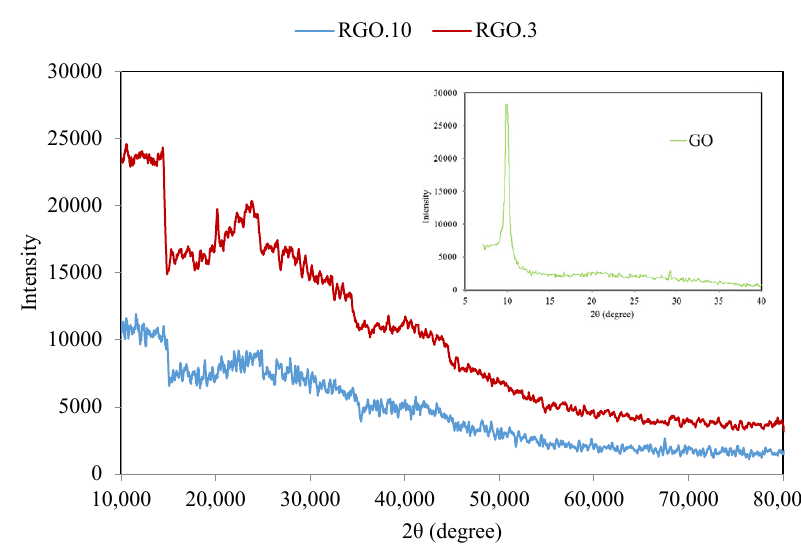
Fig. 1. The XRD patterns of GO, RGO.3, and RGO.10